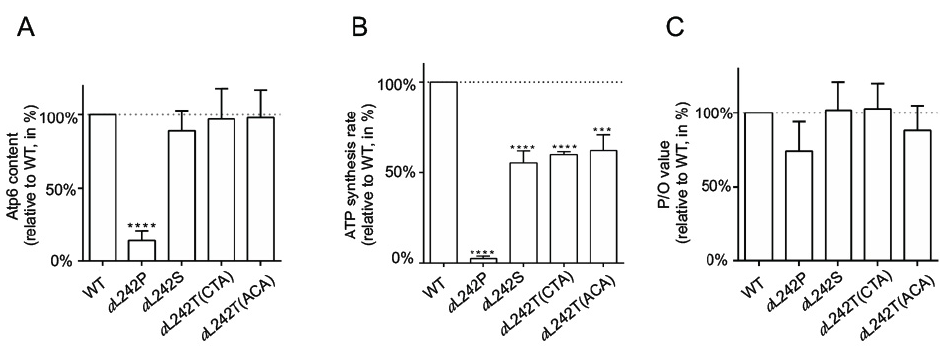
Figure 3. Influence of the a L242P, a L242S and a L242T mutations on ATP synthase accumulation and activity. The shown histograms recapitulate the relative influence on subunit a / Atp6 accumulation ( A ) F 1 F O -mediated ATP synthesis ( B ) and the yield in ATP per electron transferred to oxygen (P / O value) ( C ) of the a L242P, a L242S and a L242T mutations in comparison to WT . They were built from data reported in Figure 2B and Table 2. **** indicates a p < 0.0001; *** indicates a p < 0.001.